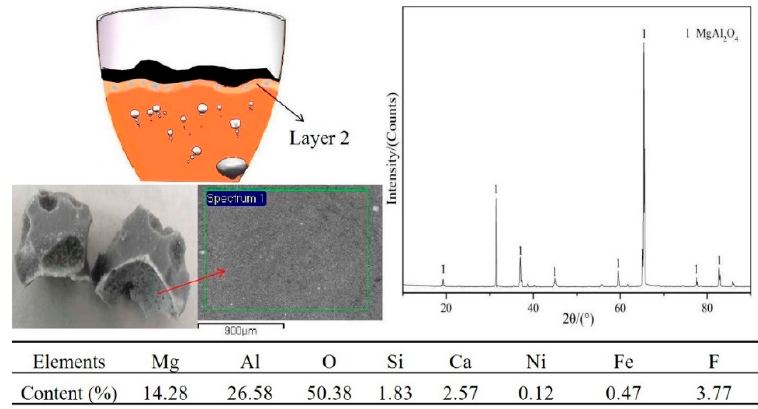
Figure 7. XRD pattern and EDS analysis of Layer 2.